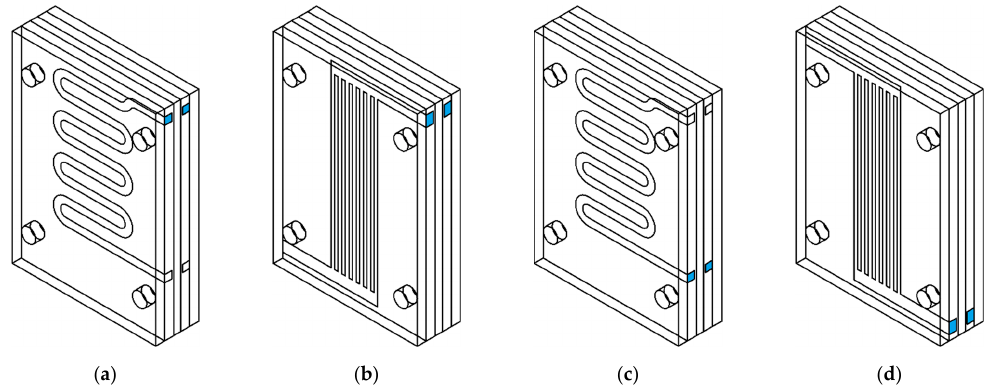
Figure 10. The cooling media inlets and outlets (respectively) for: ( a , c ) square and rounded channel, ( b , d ) finned channel.